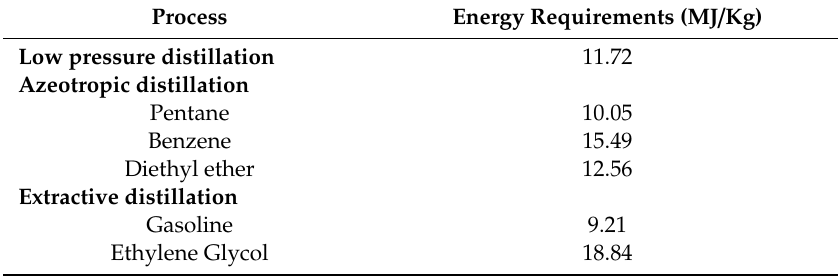
Table 7. Energy requirements for traditional industrial ethanol distillation and dehydration processes